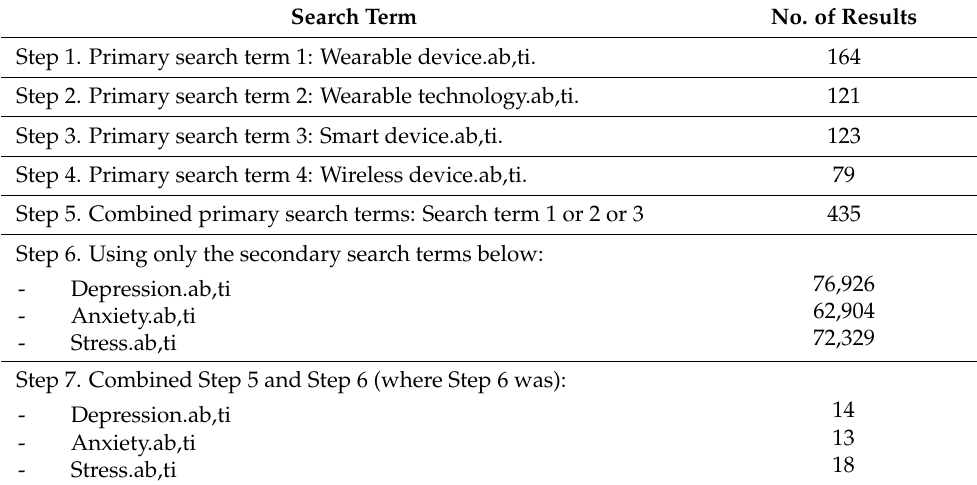
Table 4. The search structure for the PsycINFO database. Search